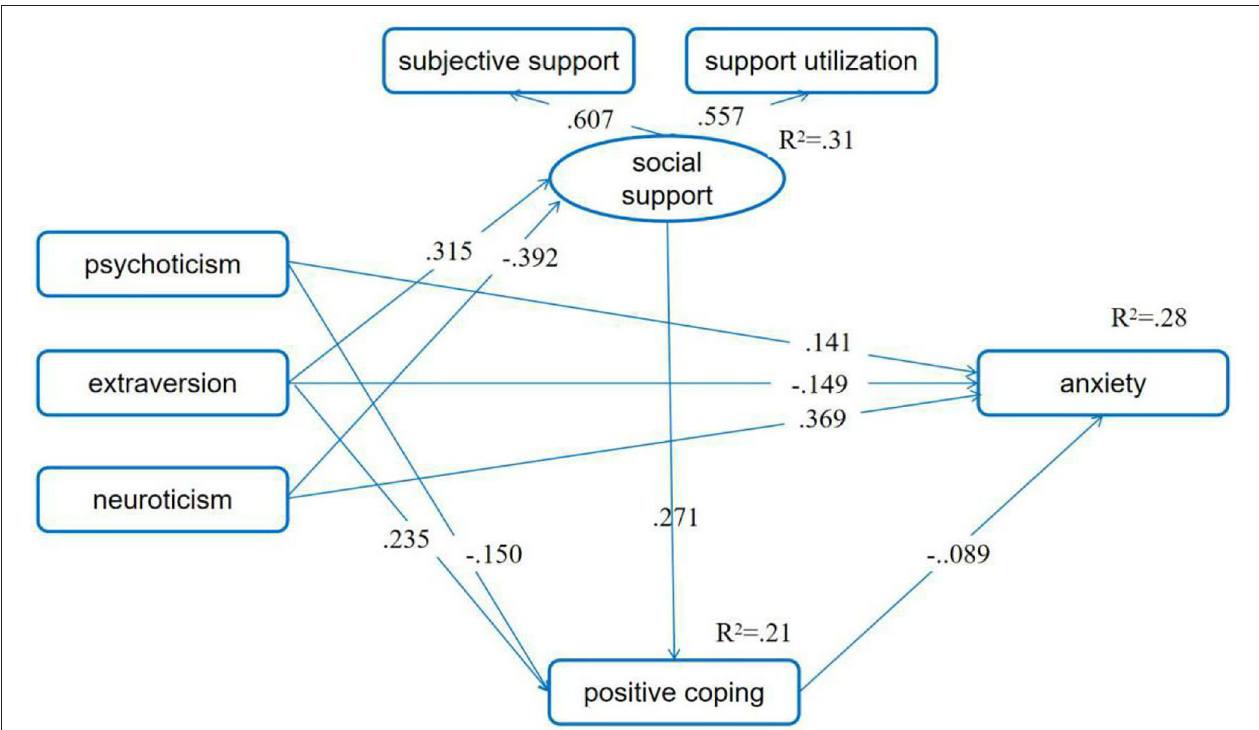
FIGURE 2 | Positive coping as mediator between personality and anxiety symptoms. Standardized path coefficients are presented in the model ( p s < 0.05). The first pregnancy or not, having adverse pregnancy experience or not, being pregnant as planned or not, and number of weeks of pregnancy were set as control variables.